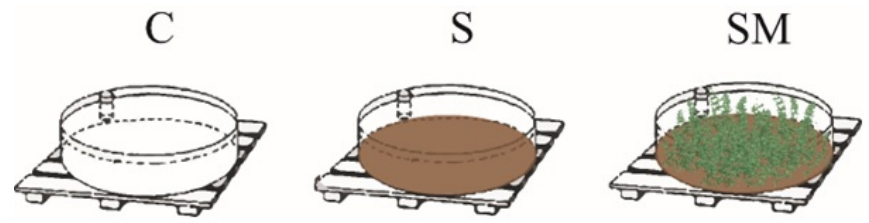
Figure 2. Class A pans with different treatments: C, S, and SM denote “empty”, sediment-covered, and macrophyte-planted class A pans in the middle of the meteorological